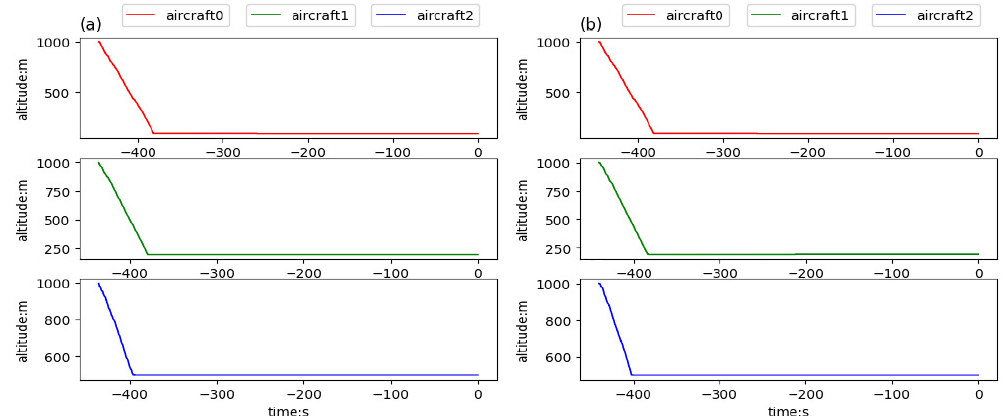
Figure 17. Altitudes of aircraft trained in team aircraft guidance: ( a ) three aircraft starting in the same aerospace, flying to the aimed for 4D waypoints, respectively, and ( b ) three aircraft starting in different aerospaces, flying to the aimed for 4D waypoints, respectively.